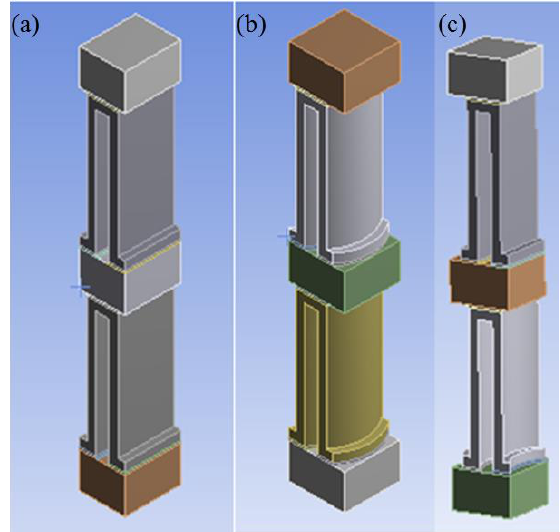
Figure 4. Three configuration of fins. ( a ) Plain fin configuration. ( b ) Wavy fin configuration. ( c ) Compound fin configuration.